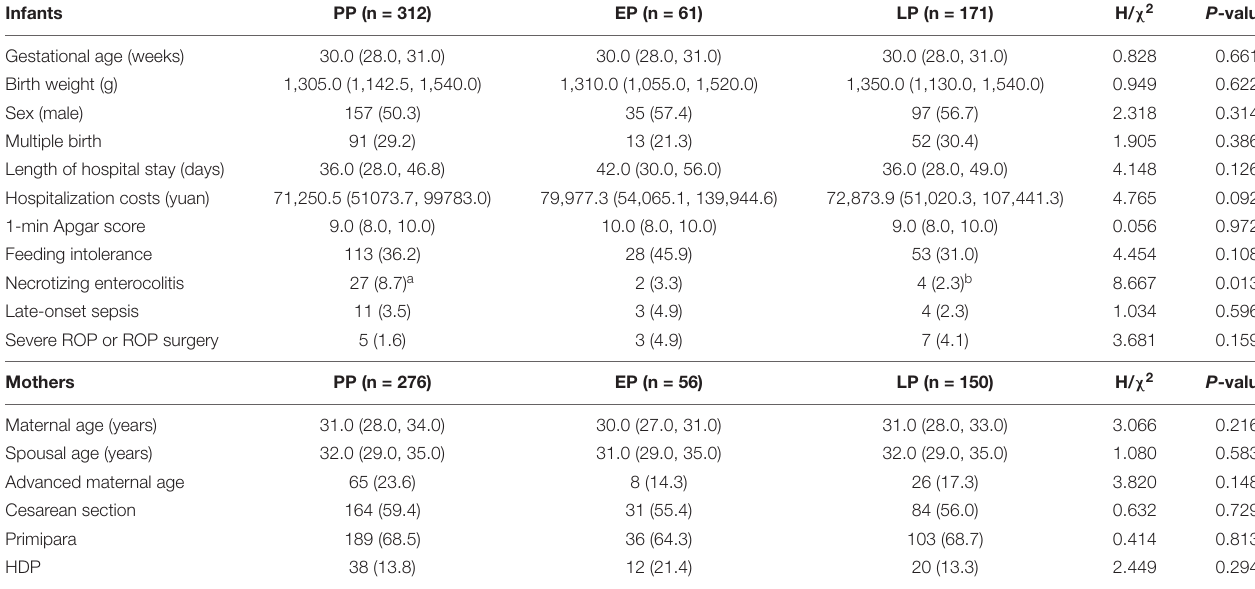
TABLE 1 | Basic characteristics and comorbidities of the enrolled infants and maternal demographic data.